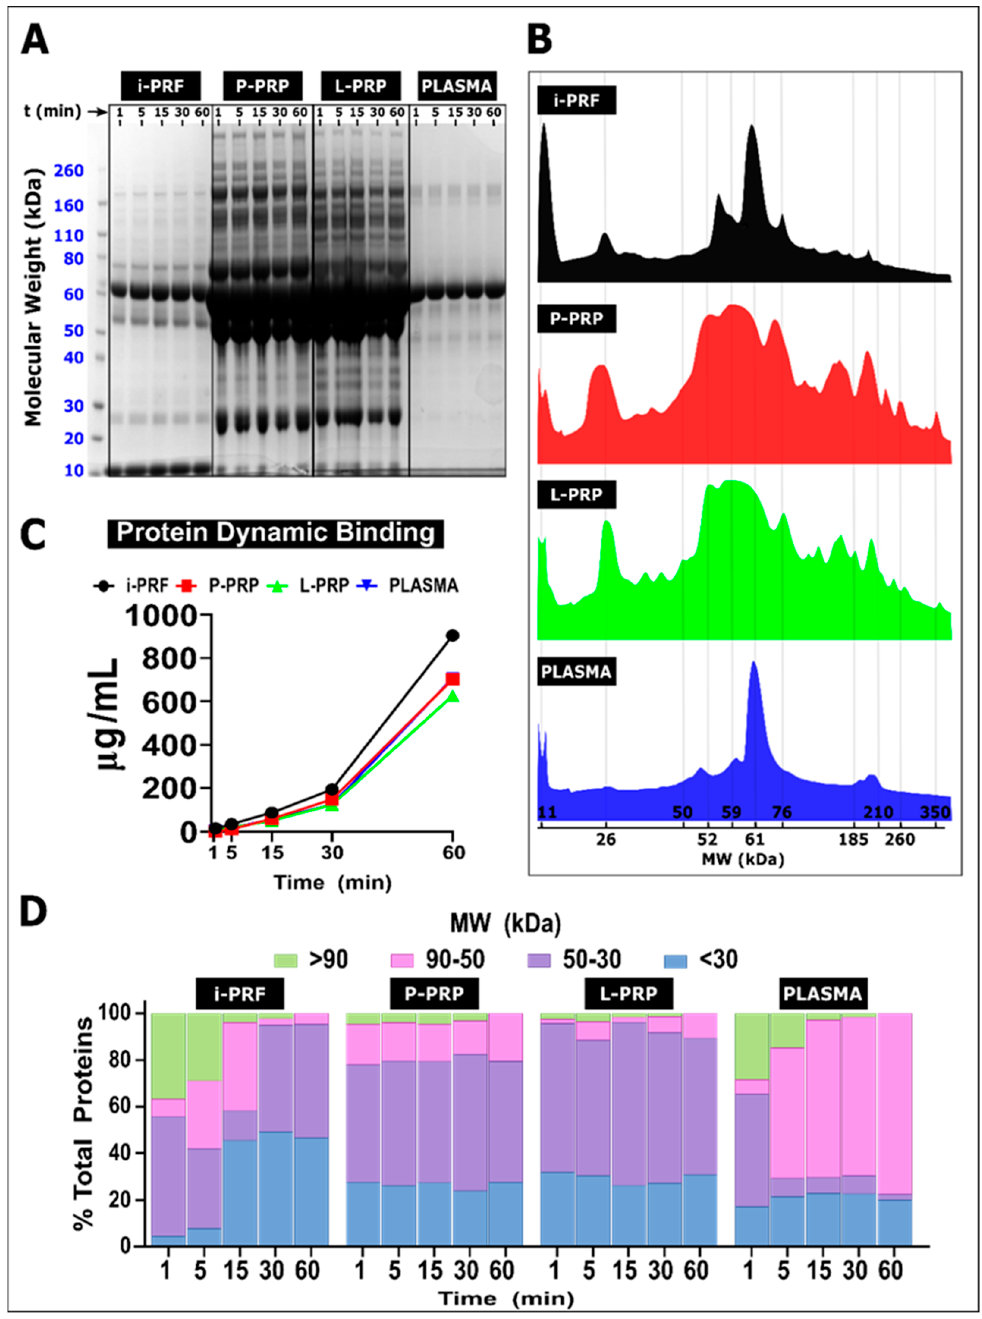
Figure 6. PC characterization. ( A ) SD–PAGE gel of the di ff erent groups at the 5 time points. ( B ) Spectrum of the protein intensity at 60 min segmented by their molecular weight (MW), showing the di ff erential PC behavior analyzed by the area under the curve. ( C ) Total protein dynamic binding of di ff erent groups. ( D ) The protein deposition on the surface demonstrated di ff erential protein composition by MW distribution on the PCL/CaP surface interface over time. At the early stages, predominantly high MW (>90 kDa) protein deposition was observed, followed by a secondary protein binding with medium and low MW (>30 kDa).